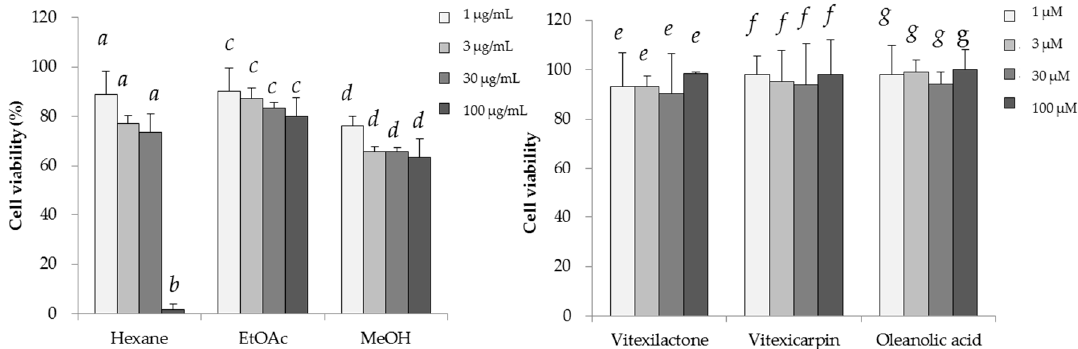
Figure 1. Cytotoxic effects of the three extracts and three compounds isolated from V. trifolia in 3T3-L1 cells. Data are expressed as the mean ± SD from three independent experiments. The same letters indicate that there are no differences between those groups, and different letters indicate significant differences ( p < 0.05).